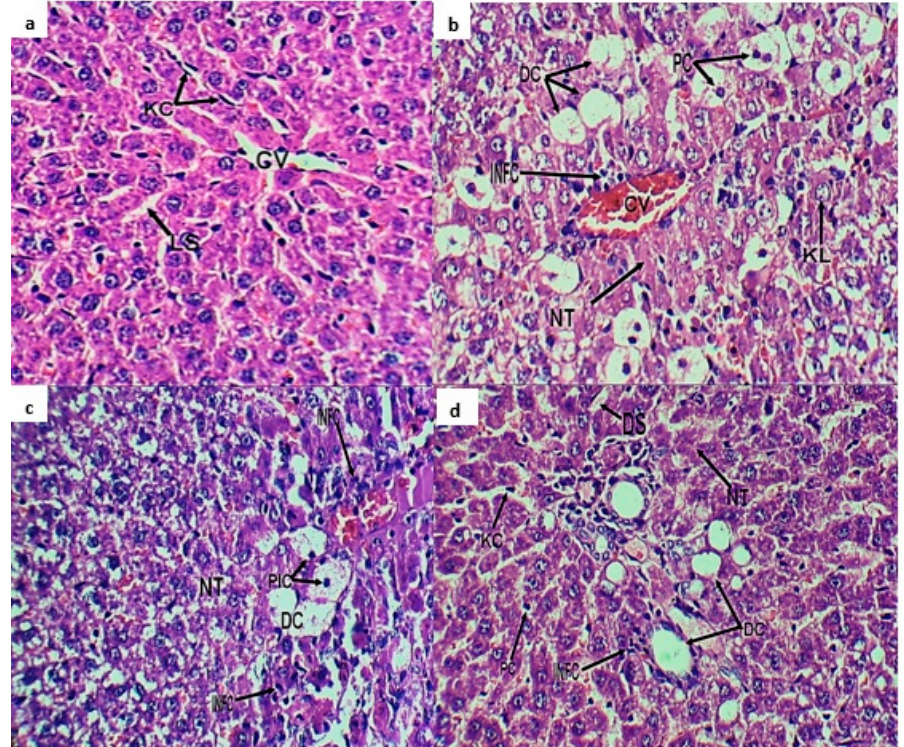
Figure 3. Photomicrograph of liver sections ( a ) normal liver with normal hepatocytes, normal hepatic cords and normal distribution of Kupffer cells (KC) with normal liver sinusoids (LS); ( b ) CCL 4 group showed marked infiltration of inflammatory cells (INF), marked degenerative changes, necrotic tissue (NT), and degenerated cells (DC) with clear pyknotic reaction (PC); ( c ) silymarin group showed moderate hepatocyte degeneration; ( d ) methanol extract group exhibited mild nuclear changes and apoptosis, mild necrotic changes, normal appearance of Kupffer cells, and mild dilatation of liver sinusoids with normal tissue histological-architecture. Central vein (CV), infiltration of inflammatory cells (INFC), karyolysis (KL), pyknotic changes (PIC), and dilated liver sinusoids